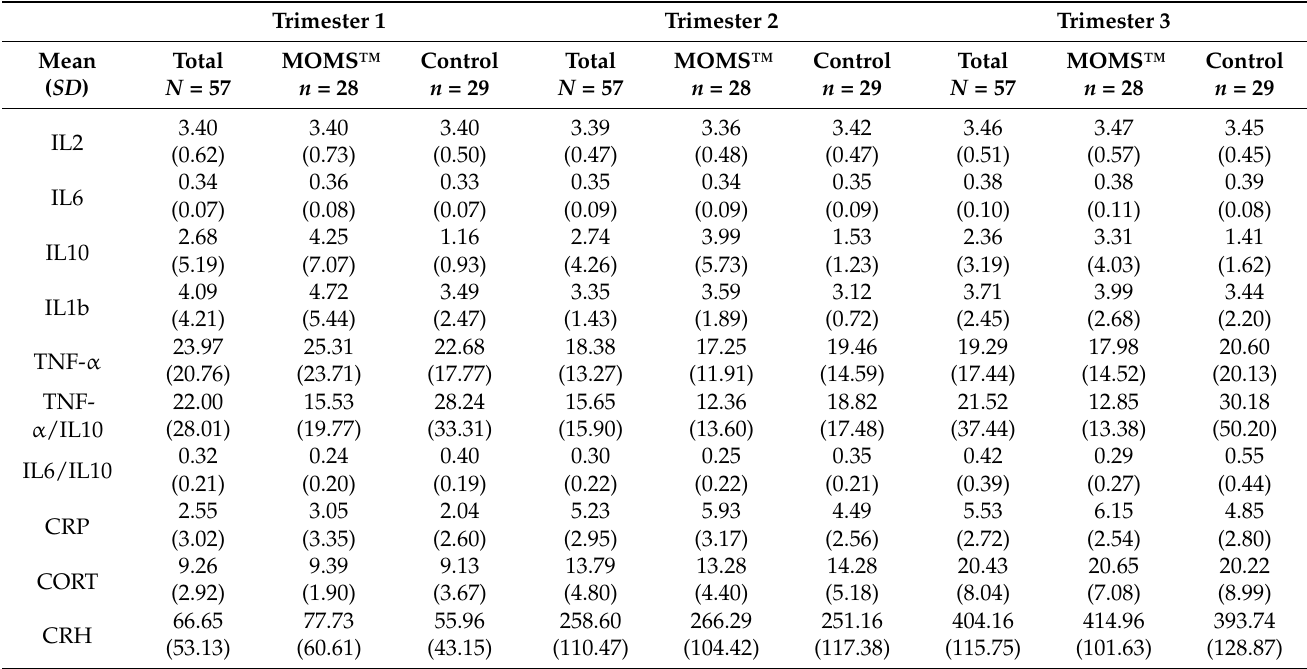
Table 2. Descriptive statistics for maternal serum biomarkers by trimester.